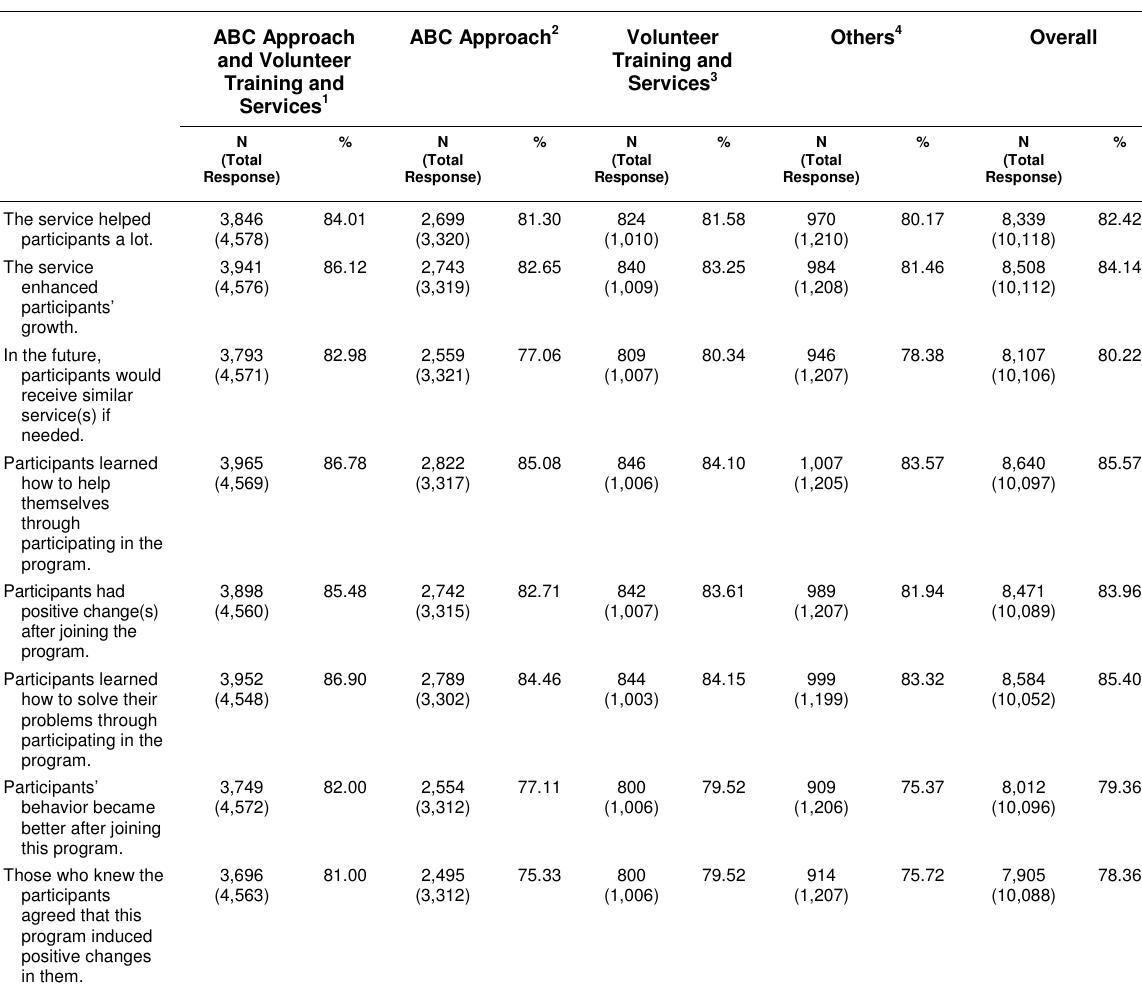
Comparison of the Positive Views Towards the Tier 2 Program Effectiveness Among